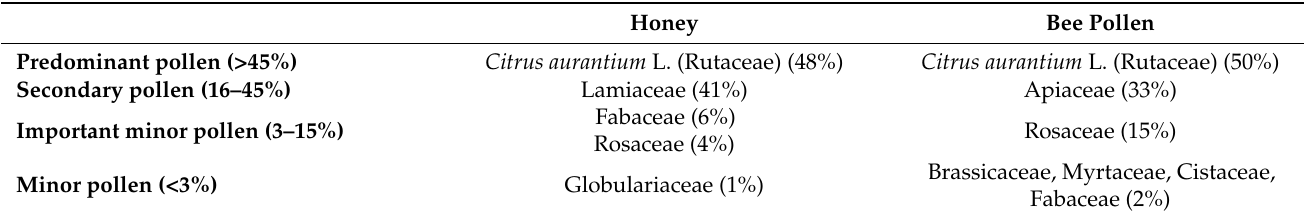
Table 2. Melissopalynological analysis of honey and bee pollen.